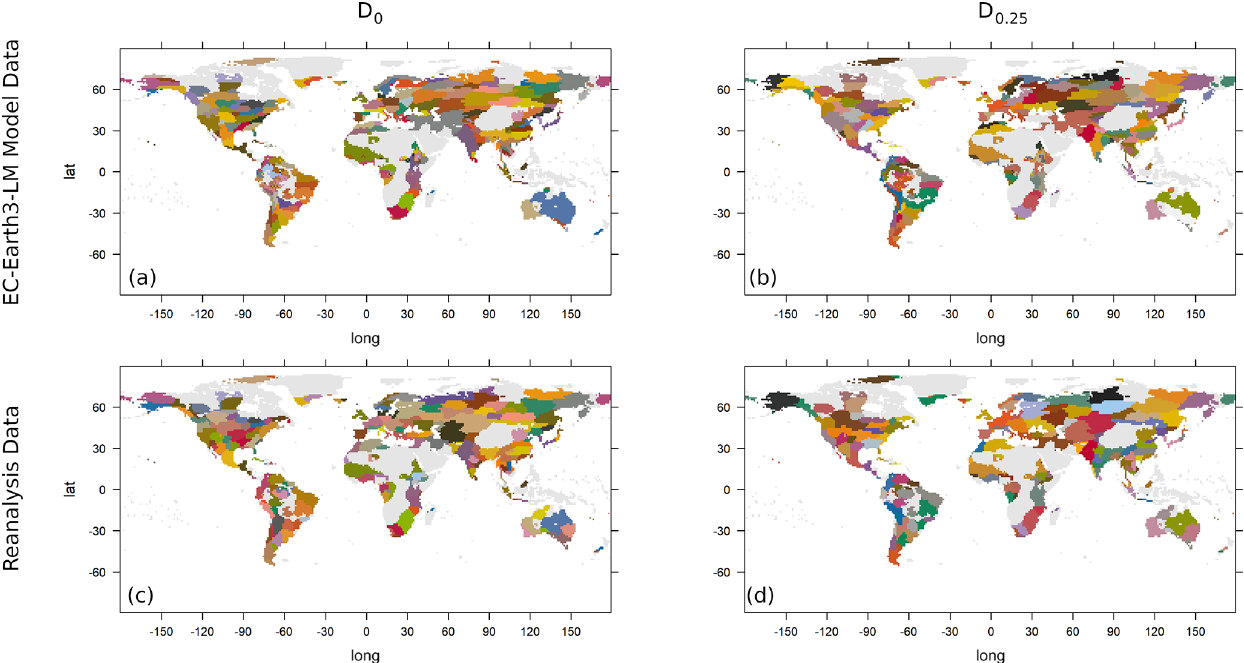
Figure 11. Clustering of the EC-Earth3-Veg-LR model data (a, b) and the observational data (c, d) with the dissimilarity measure D 0 and threshold h = 0 . 825 (a, c) and with dissimilarity measure D 0 . 25 and threshold h = 0 . 65 (b, d)